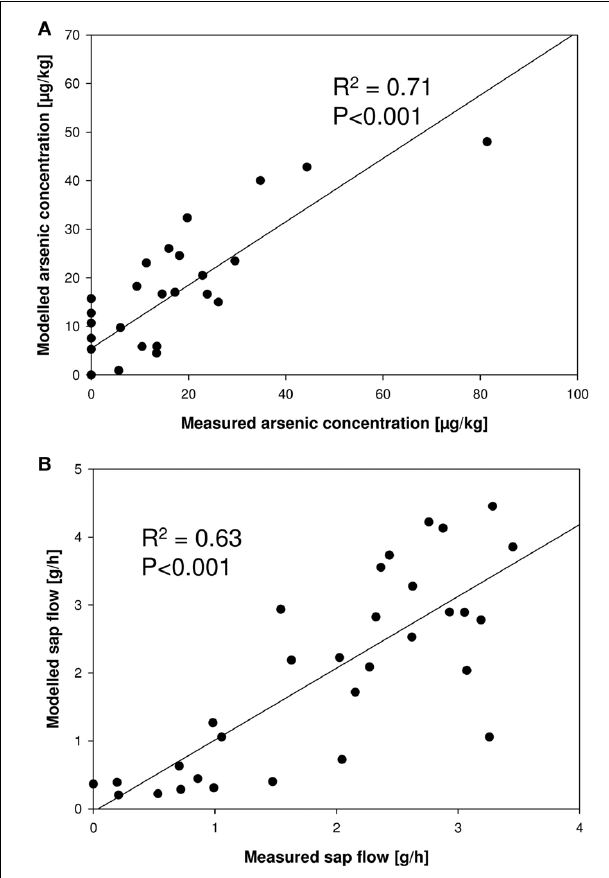
FIGURE 2 | Plot of modeled arsenic concentration in sap vs measured arsenic concentration in sap (A) and modeled sap flow calculated by multiple linear regression vs measured sap flow (B).